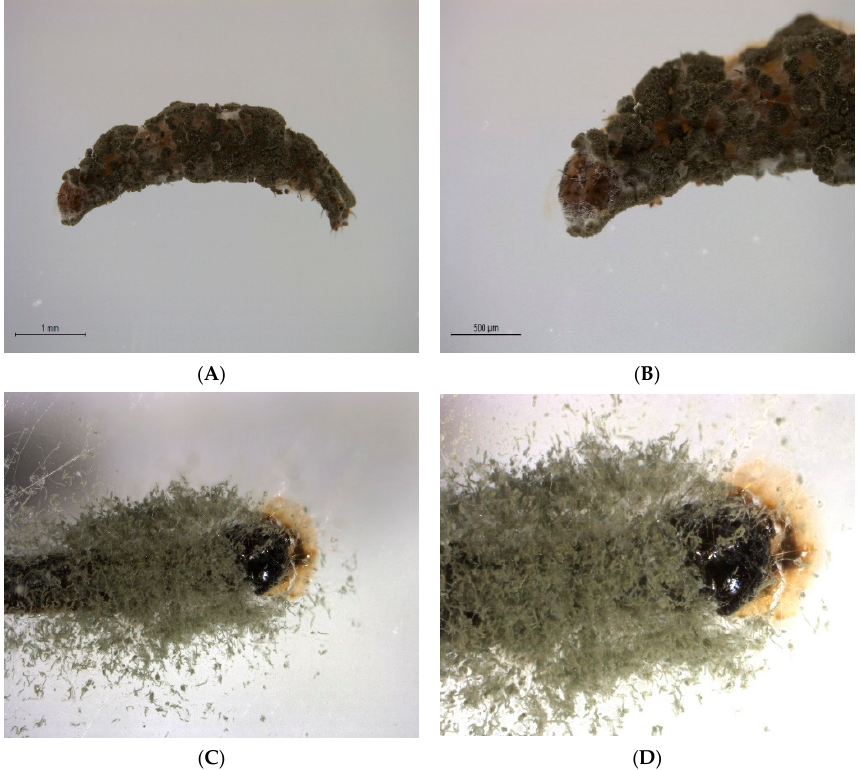
Figure 2. Conidial growth of Metarhizium anisopliae on larvae of Plutella xylostella . Larvae were placed in a humid chamber for confirmation of death due to fungi. ( A ) Conidial growth over the full body of the dead larvae. ( B ) Zoomed in the image of the conidia growing on the head of the dead larvae. ( C ) Conidial growth around the head and thorax of larvae. ( D ) Zoomed in the image of conidial growth adjacent to the head. Table 2. Lethal and sublethal concentrations of fungi against Plutella xylostella.